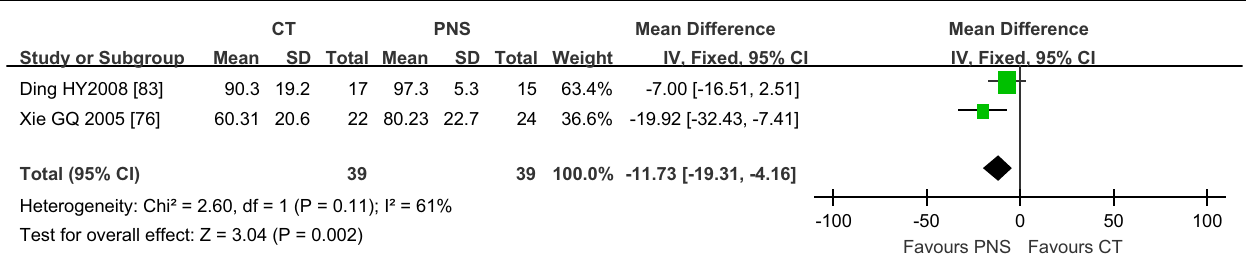
Study or Subgroup